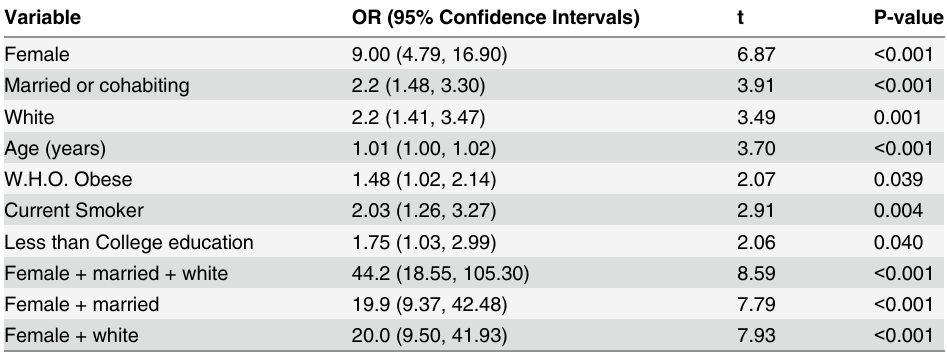
Table 6. Multivariable logistic regression of predictors of physician diagnosis of fibromyalgia: Model predicting persons told by a physician that they that fibromyalgia (excluding Polysymptomatic Dis- tress